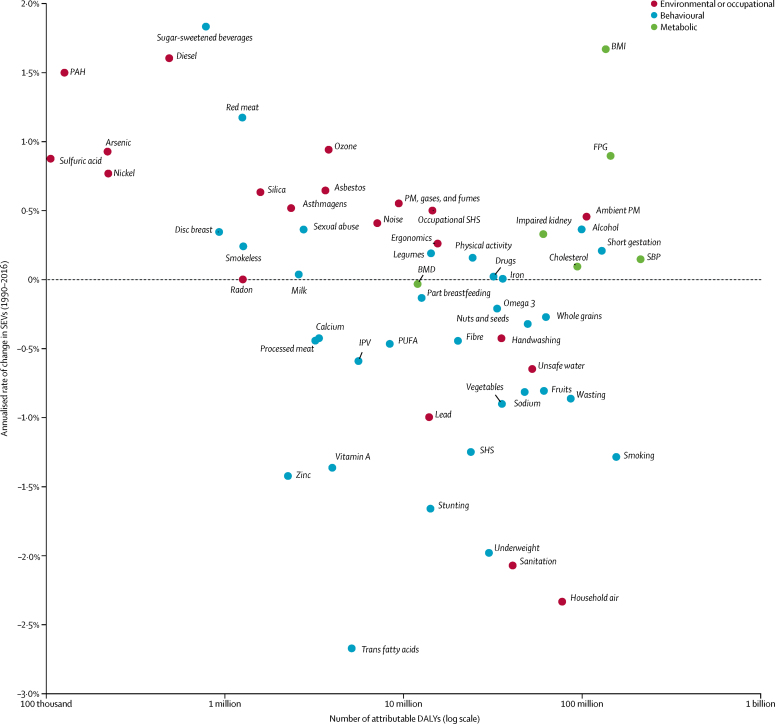
Relationship between attributable DALYs in 2016 for Level 3 risk factors and annualised rate of change in SEV, at the global level, both sexes combined, 1990–2016DALYs are represented on a logarithmic scale. Risks shown exhibited a statistically significant change in SEV between 1990 and 2016. The following six risks, each of which is responsible for fewer than 100 thousand DALYs, are not shown: occupational exposure to benzene, beryllium, cadmium, chromium, formaldehyde, and trichloroethylene. DALYs=disability-adjusted life-years. SEV=summary exposure value. Ambient PM=ambient particulate matter pollution. Alcohol=alcohol use. Arsenic=occupational exposure to arsenic. Asbestos=occupational exposure to asbestos. Asthmagens=occupational asthmagens. BMD=low bone mineral density. BMI=high body-mass index. Calcium=diet low in calcium. Cholesterol=high total cholesterol. Diesel=occupational exposure to diesel engine exhaust. Disc breast=discontinued breastfeeding. Drugs=drug use. Ergonomics=occupational ergonomic factors. Fibre=diet low in fibre. FPG=high fasting plasma glucose. Fruits=diet low in fruits. Handwashing=no access to handwashing facility. Household air=household air pollution from solid fuels. Impaired kidney=impaired kidney function. IPV=intimate partner violence. Iron=iron deficiency. Lead=lead exposure. Legumes=diet low in legumes. Milk=diet low in milk. Nickel=occupational exposure to nickel. Noise=occupational noise. Nuts and seeds=diet low in nuts and seeds. Occupational SHS=occupational exposure to second-hand smoke. Omega 3=diet low in seafood omega 3 fatty acids. Ozone=ambient ozone pollution. PAH=occupational exposure to polycyclic aromatic hydrocarbons. Part breastfeeding=non-exclusive breastfeeding. Physical activity=low physical activity. PM, gases, and fumes=occupational particulate matter, gases, and fumes. Processed meat=diet high in processed meat. PUFA=diet low in polyunsaturated fatty acids. Radon=residential radon. Red meat=diet high in red meat. Sanitation=unsafe sanitation. SBP=high systolic blood pressure. Sexual abuse=childhood sexual abuse. SHS=second-hand smoke. Silica=occupational exposure to silica. Smokeless=smokeless tobacco. Sodium=diet high in sodium. Stunting=child stunting. Sugar-sweetened beverages=diet high in sugar-sweetened beverages. Sulfuric acid=occupational exposure to sulfuric acid. Transfatty acids=diet high in transfatty acids. Underweight=child underweight. Vegetables=diet low in vegetables. Vitamin A=vitamin A deficiency. Wasting=child wasting. Water=unsafe water source. Whole grains=diet low in whole grains. Zinc=zinc deficiency.